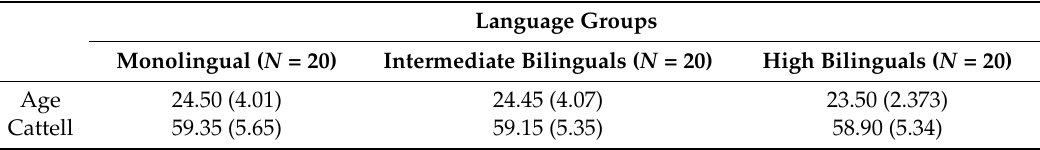
Table 3. Descriptive statistics of age and Cattell scores of three language